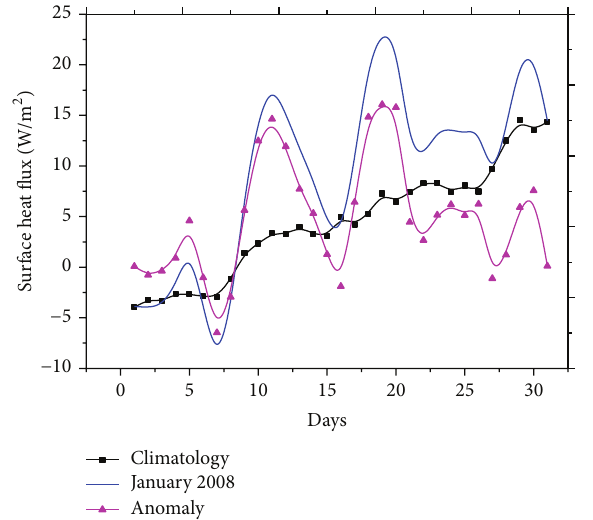
Figure 1: Time evolution of TP surface heat flux in January 2008.